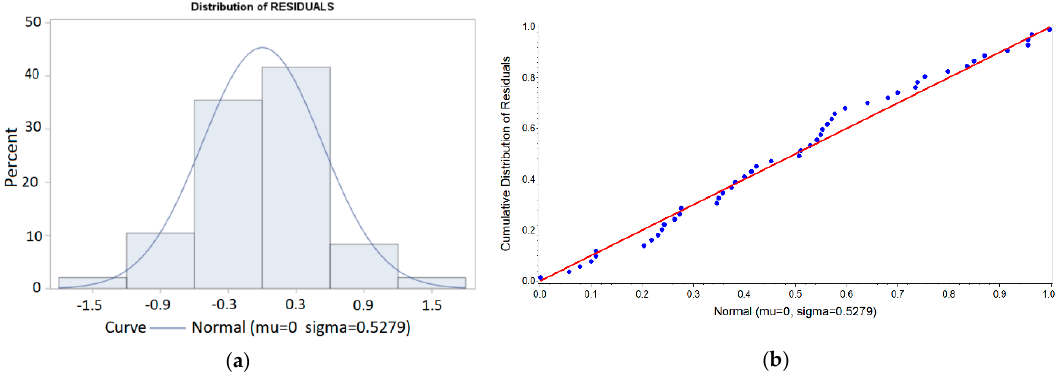
Figure 10. Checking the hypothesis of normality for the residuals: ( a ) histogram of residuals and ( b ) Probability–Probability plot for residuals. Table 10. Tests for normality on residuals.